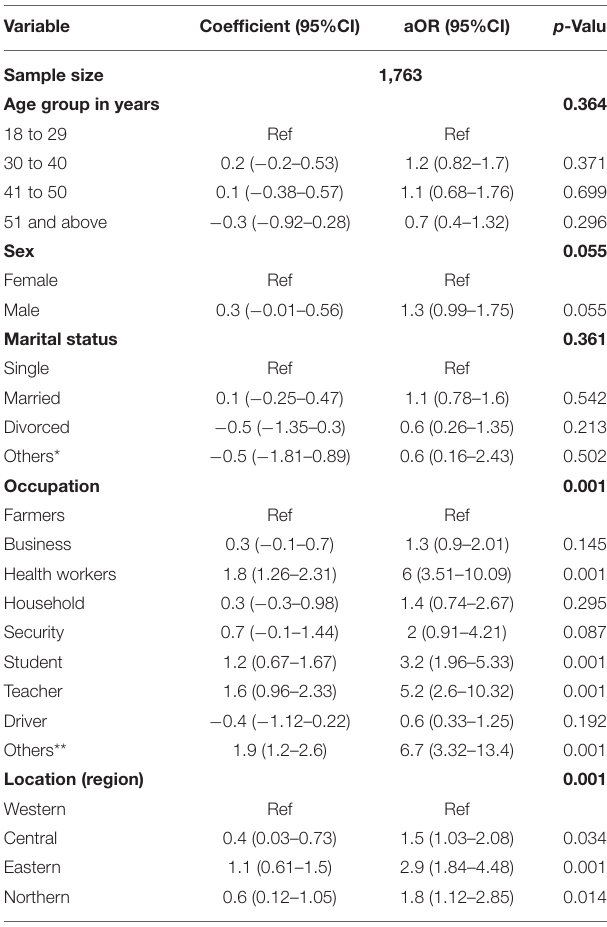
TABLE 1 | Socio-demographic characteristics of participants. Variable